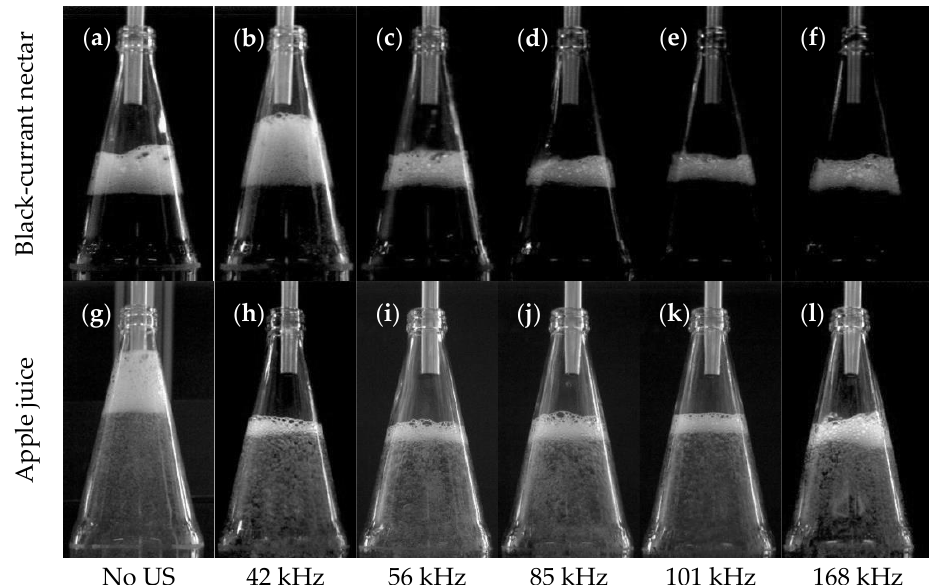
Figure 7. Insonification causes coarser, reduced foams of black currant nectar ( a – f ) and apple juice ( g – l ) and larger ascending bubbles in apple juice at the end of filling t = 10 s ( h – l ).